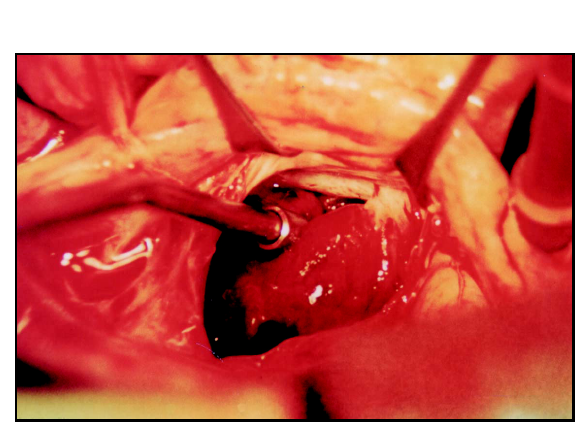
Fig. 4 - Aspectos cirúrgicos, mostrando, através de atriotomia esquer- da, o mixoma com seu pedículo implantado no septo interatrial e ocupando grande parte do AE.